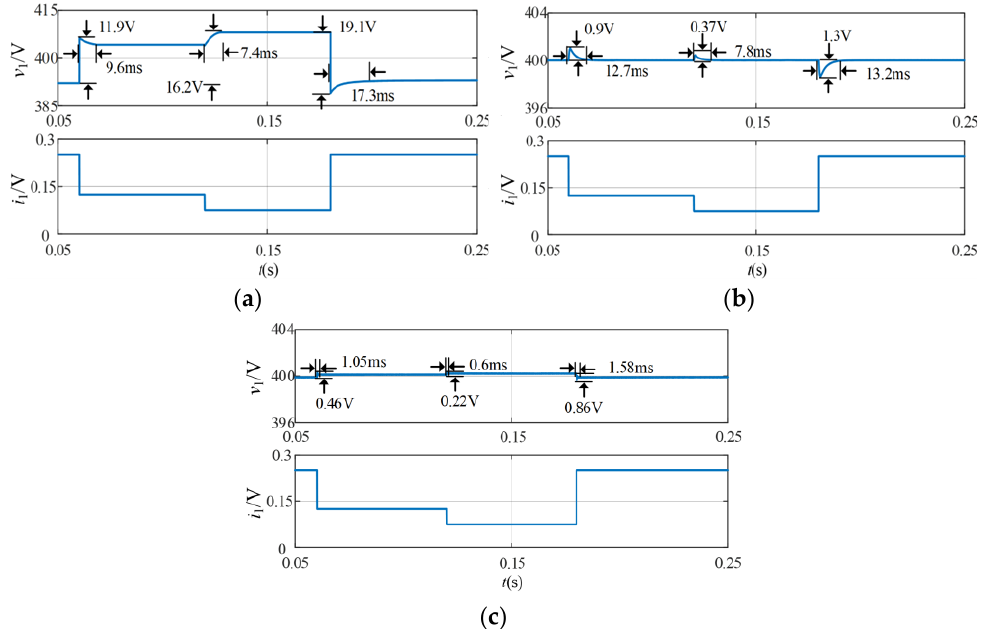
Figure 12. The dynamic waveforms of v 1 when i 1 changes in step-up mode: ( a ) PBC; ( b ) PBC with PI;